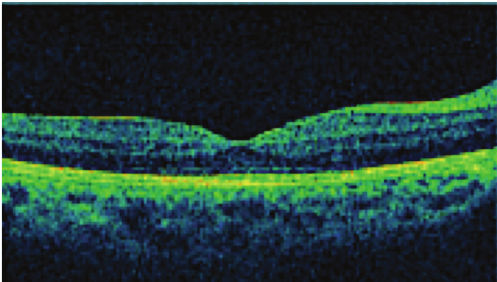
Figure 2: Complete resolution with macular thickness of 278 𝜇 after treatment with